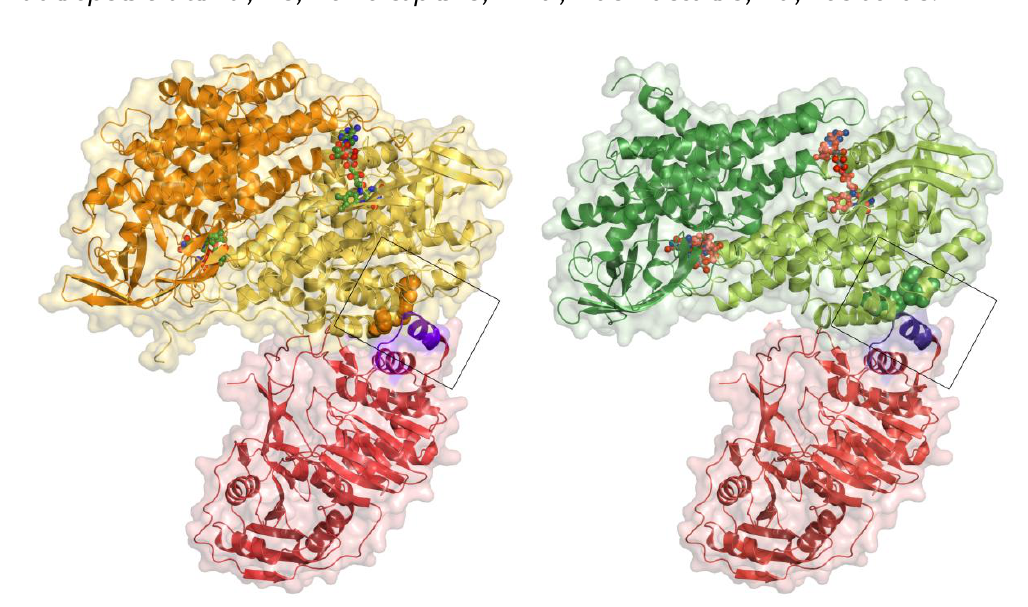
Figure 6. Model of the docking between AidB and the human ETF. ( A ) Side-by-side views of the AidB-ETF docking model (left) and the MCAD-ETF complex structure (right), shown in the same orientation. For the docking, the crystal structure of AidB (PDB ID: 3U33 [21]) was superimposed onto the MCAD-ETF complex structure (PDB ID: 1T9G [29]). All structures are shown in ribbon representation, with the ETF in red, AidB protomers in yellow and orange, and MCAD protomers in dark and light green. Only one dimer is shown both for the AidB tetramer and the MCAD tetramer, the second dimer is omitted for clarity in both cases. Transparent surfaces are shown around all proteins in red (ETF), yellow (AidB) and green (MCAD). Bound FAD-cofactors of AidB and MCAD are shown in ball-and-stick representation with carbon atoms in light green and orange, respectively. The ETF recognition loop is shown in purple and interacting hydrophobic residues of AidB and MCAD are shown as orange and green spheres, respectively; ( B ) Wall-eyed stereo view of the ETF recognition loop interactions. The docking was generated in the same fashion as in (A). The recognition loop is shown in purple ribbons, with Leu195 shown as sticks. MCAD residues from the MCAD-ETF complex structure that are interacting with the recognition loop are shown with pale green carbons. AidB residues near the putative location of ETF Leu195 are shown with yellow carbons. The axes of the recognition loop helix, MCAD helix C, and the corresponding AidB helix are shown and colored by dipole moment from blue (positive) to red (negative); ( C ) Multiple sequence alignment of ETFs from different organisms. The residue that inserts into the hydrophobic pocket of partner proteins is highlighted in yellow. Other conserved residues are shown in